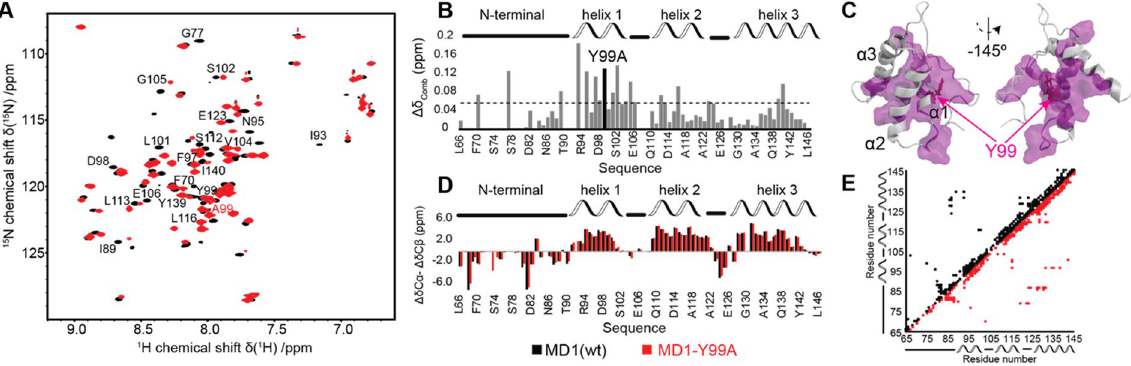
Figure 5. NMR-based structural comparison of MD1 and MD1 Y99A . ( A ) 1 H- 15 N-HSCQ spectra of MD1 (black) and MD1 Y99A (red). Labels correspond to the most affected residues due to the mutation. ( B ) Chemical shift perturbations induced by the mutation along the MD1 sequence and ( C ) mapped on the MD1 structure (purple, mutation site highlighted). ( D ) Comparison of 13 C secondary chemical shifts of MD1 (black) and MD1 Y99A (red). Positive/negative values indicate α -helical/ β -strand secondary structure. Random coil values should be zero. ( E ) Inter-residue distance restraints from NOEs for MD1 (black) and MD1 Y99A